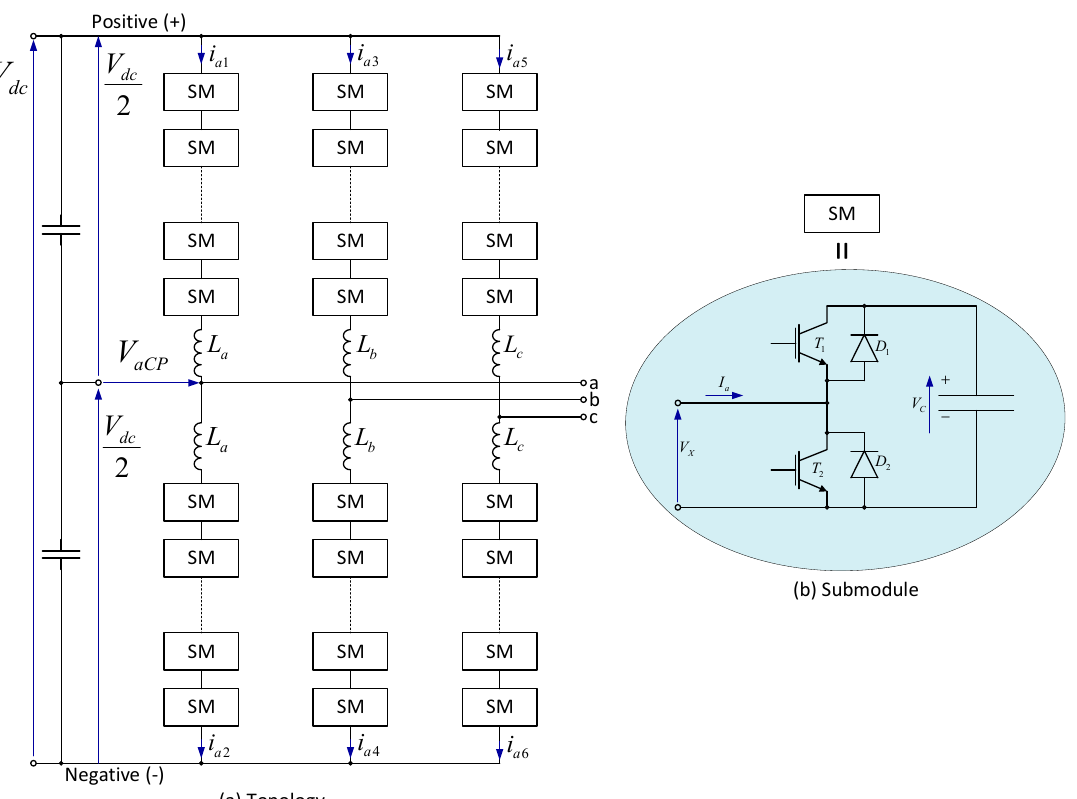
Figure 21. 3-Level Neutral-clamped converter.